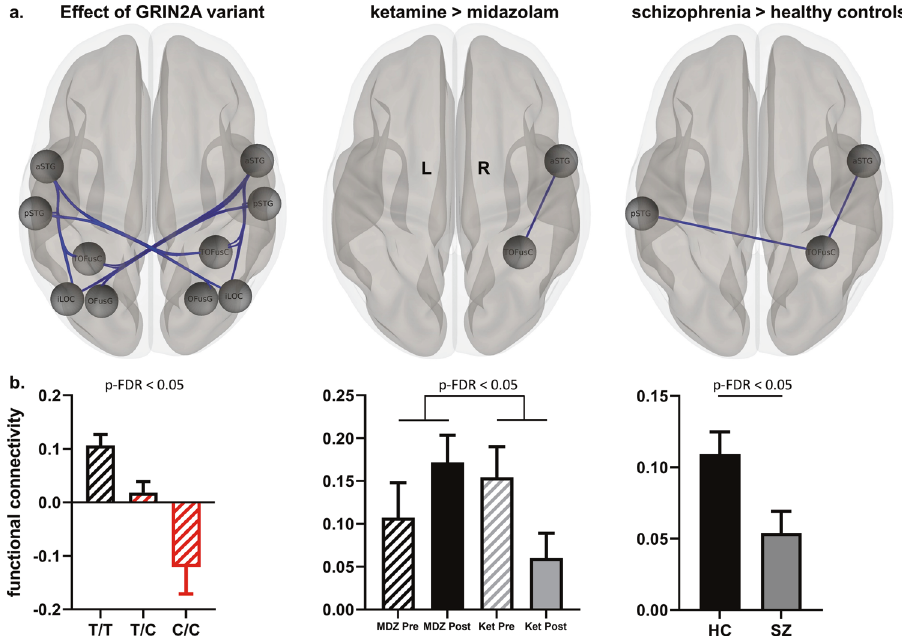
Fig. 5 Reduced connectivity between auditory and visual regions. A hypothesis-free whole-brain functional network connectivity analysis revealed that the genetic variant was associated with reduced functional connectivity between an auditory (superior temporal) and visual (temporo-occipital) network ( a , left panel). For visualization, all impaired ROI-to-ROI connections with an uncorrected p -value < 0.05 are depicted as blue lines connecting the respective ROIs. Among those, the two connections exhibiting the strongest effect (aSTGr-TOFusCr and pSTGl – TOFusCr) were subsequently tested in the pharmaco-fMRI dataset using the contrast ketamine > midazolam ( a , middle panel) and in the combined schizophrenia/control dataset using the contrast schizophrenia > healthy controls ( a , right panel). For the aSTGr-TOFusCr connection which was signi fi cantly affected in all three contrasts, the respective means and standard errors for each group/condition are illustrated as bar plots in the lower panels ( b ). aSTG anterior superior temporal gyrus, pSTG posterior superior temporal gyrus, TOFusC temporo-occipital fusiform cortex, OFusG occipital fusiform gyrus, iLOC inferior lateral occipital cortex, L left; R right, Ket ketamine, MDZ midazolam, HC healthy controls, SZ